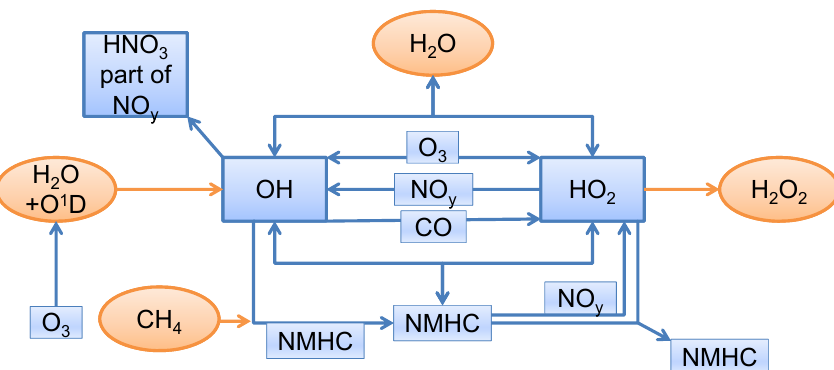
Figure 3. Atmospheric HO x chemistry used in the TAGGING scheme. Blue boxes indicate tagged species and families and orange circles non-tagged species. Arrows indicate reactions. Table 3. Reactions and reaction rates used for the calculation of OH and HO 2 contributions.